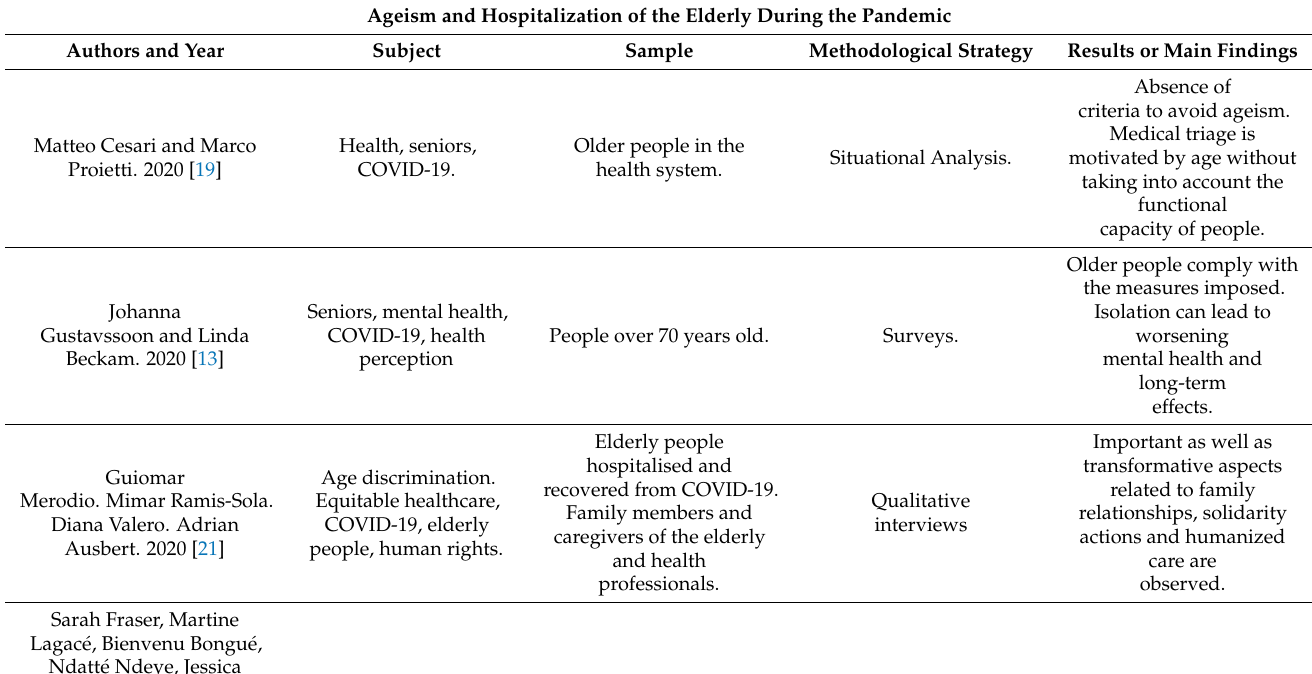
Table 4. Articles selected according to area and topic of interest. Source: own